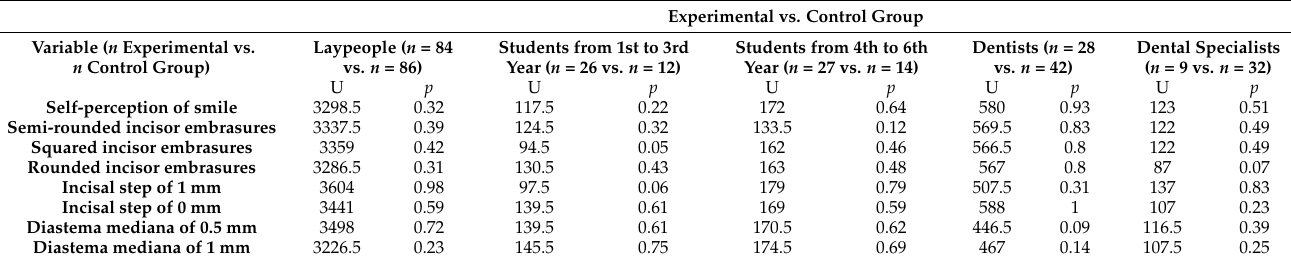
Table 3. The differences between the experimental and control groups by individual occupations in the first testing. Experimental vs. Control Group Variable ( n Experimental vs. n Control